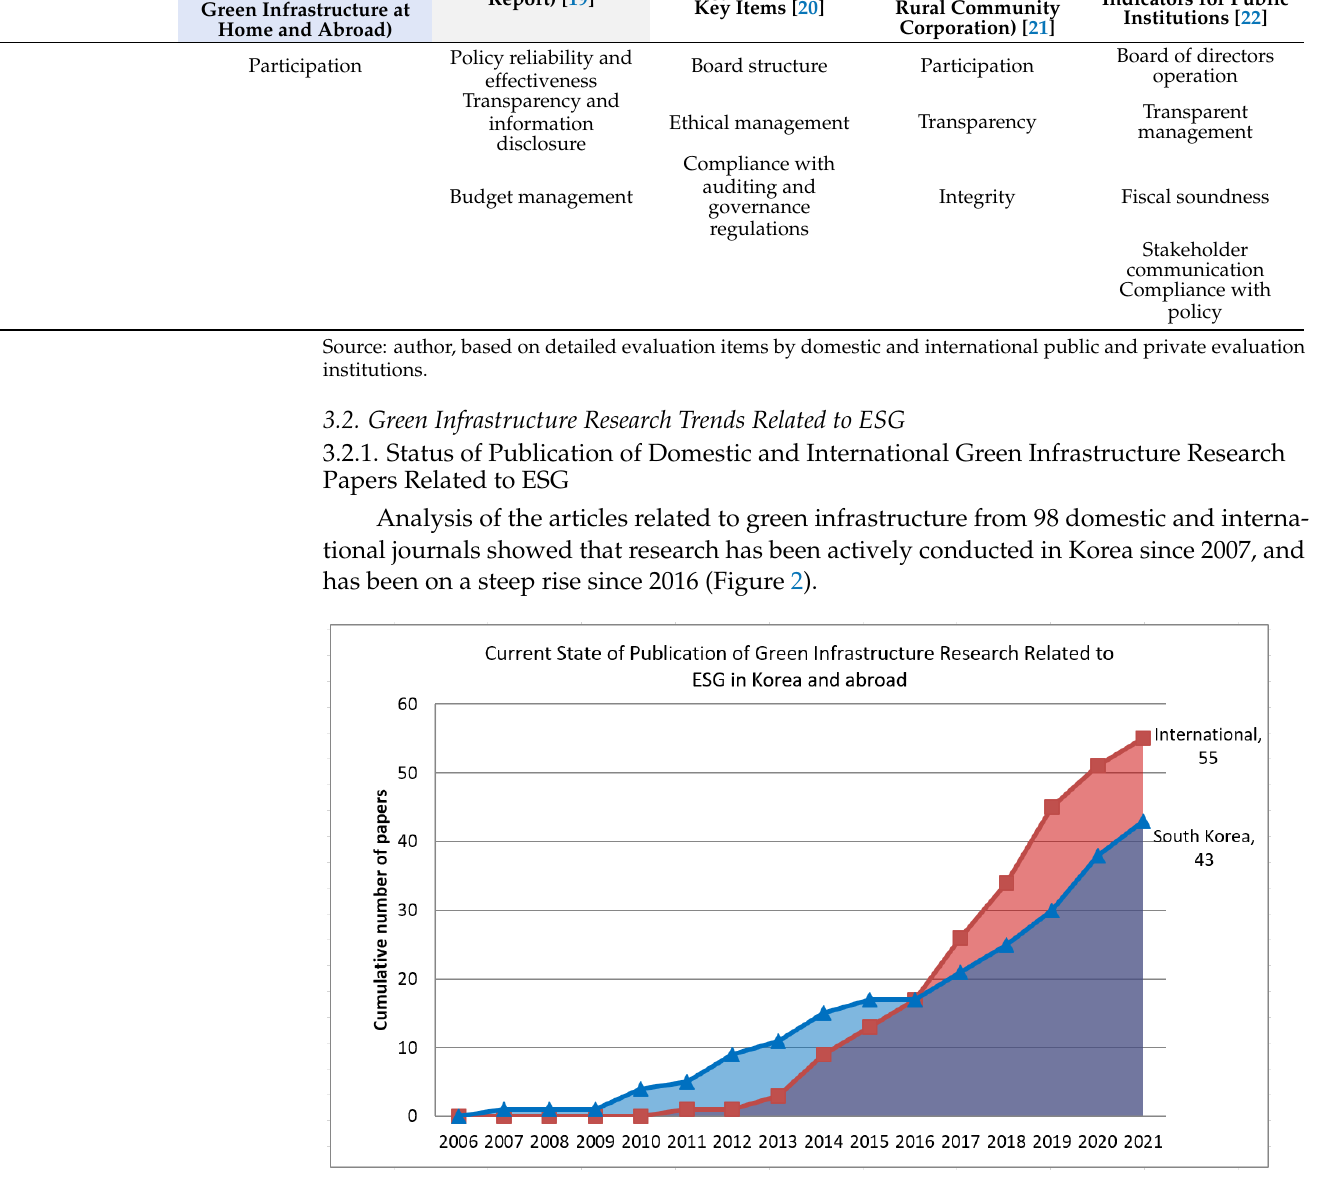
Figure 2. Current status of publication of domestic and international green infrastructure research related to ESG. Table 3. Domestic and foreign ESG evaluation indicators.